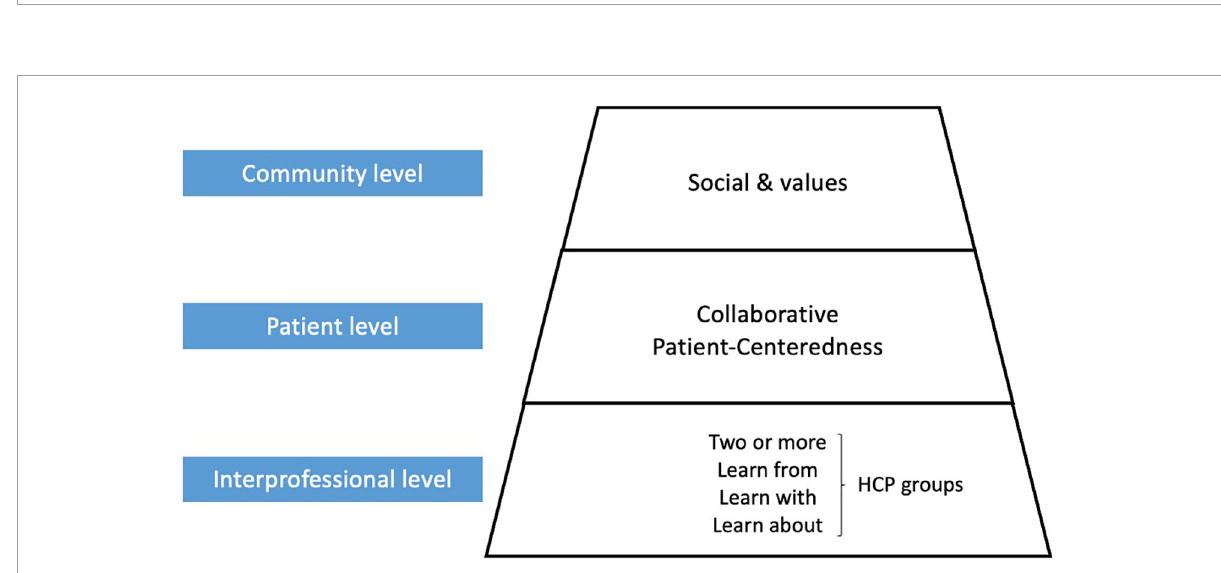
FIGURE2 Three-level interprofessional education (IPE) framework. Deductively created three-level IPE framework, according to an increased concept complexity. HCP, healthcare